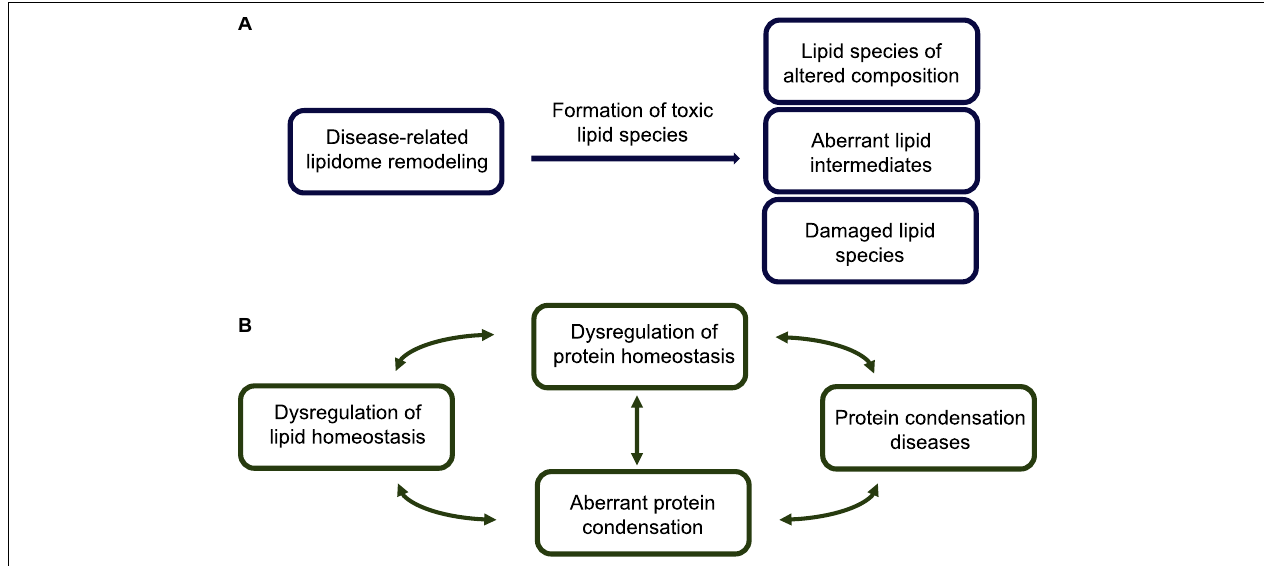
FIGURE 2 | Lipid homeostasis dysregulation, toxic lipid species, and their links to protein misfolding diseases. (A) The disease-related impairment of the lipid homeostasis system is associated with dysfunctional interactions of lipids with lipid-processing enzymes (e.g., synthases, transferases and lipases), lipid receptors (e.g., G-protein coupled receptors) and transcription factors (e.g., nuclear receptors), and results in aberrant lipidome remodeling. A modified lipidome exhibits the presence of a variety of potentially toxic lipid species, including: (1) lipid membranes, lipid droplets and lipoproteins of altered compositions, which impair lipid trafficking, (2) accumulated lipid intermediates, including partially metabolized fatty acids, and (3) damaged lipid species, such as peroxidated lipids and advanced lipoxidation end products. (B) According to the lipotoxicity hypothesis, possible routes to the development of protein misfolding diseases start from an altered lipidome, which can create cellular conditions conducive to aberrant protein assembly. This altered lipidome can both directly interact with the condensing proteins, and indirectly affect the protein homeostasis system and impair its ability to control the protein condensation process. In essence, the appearance of toxic lipid states can facilitate the formation of toxic protein states, triggering a cascade of pathological events leading to protein misfolding